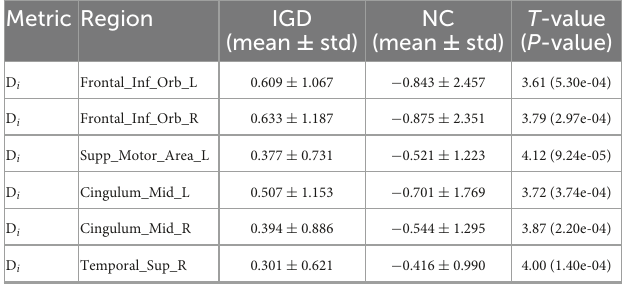
TABLE 4 Differences in the nodal degree between young people with IGD and HC. Metric Region